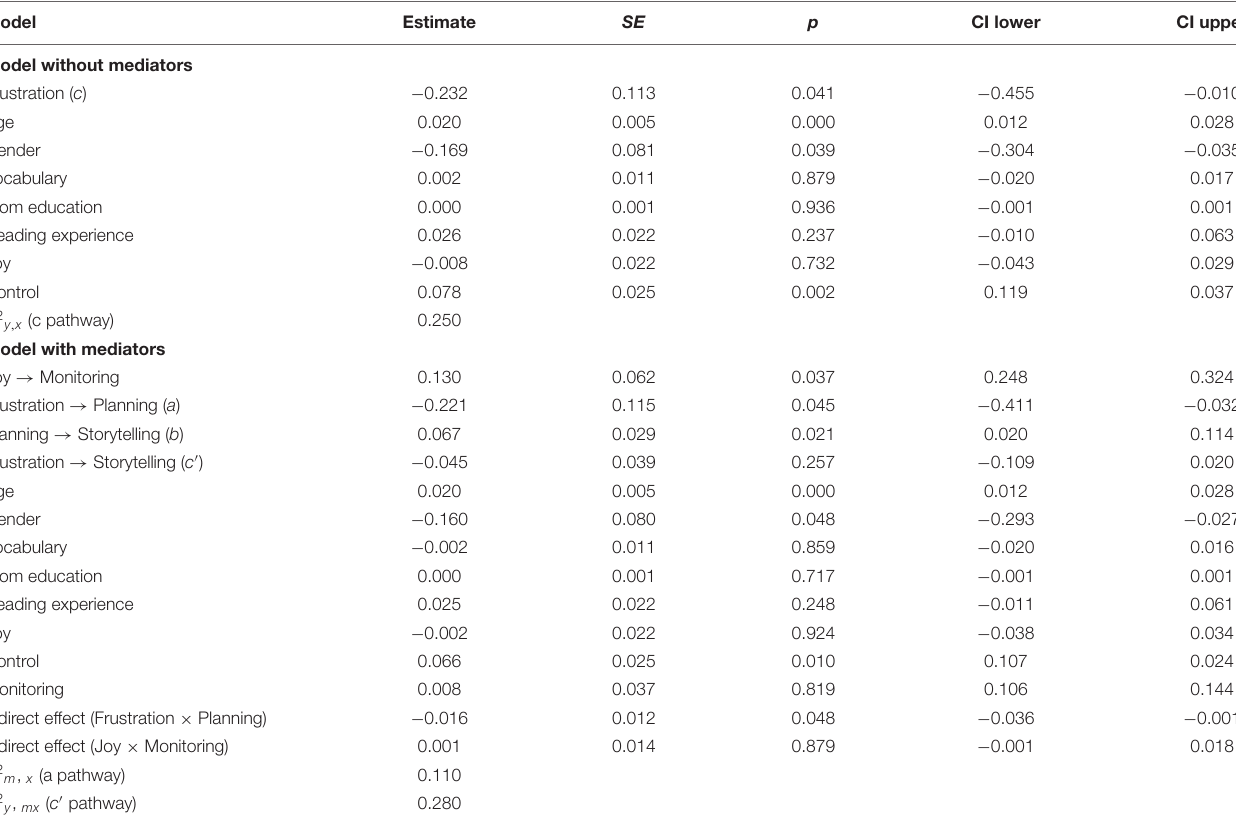
TABLE 3 | Model path coefficients, standard errors, p -values, and